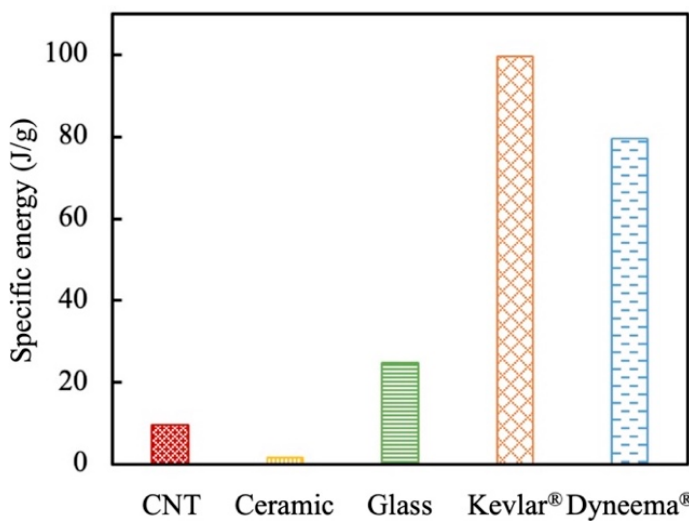
Figure 15. Comparison of specific energy of different fibers.